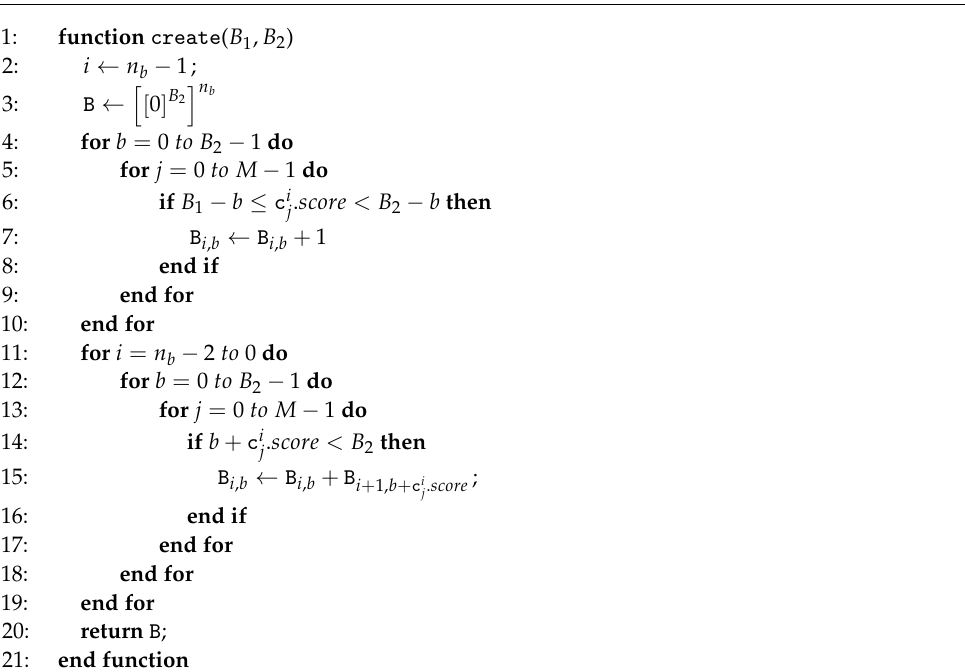
Algorithm 6 constructs the two dimensional array B